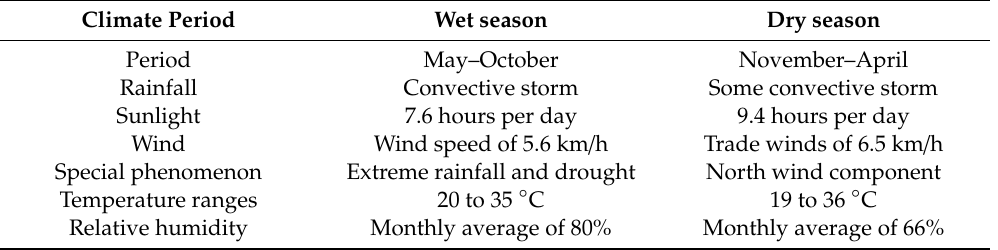
Table 1. Summary of climate parameters in the Jiboa Catchment. Reproduced from Master Plan for development and use of water resources in El-Salvador. Ministry of Agriculture and Livestock of El Salvador (1981)